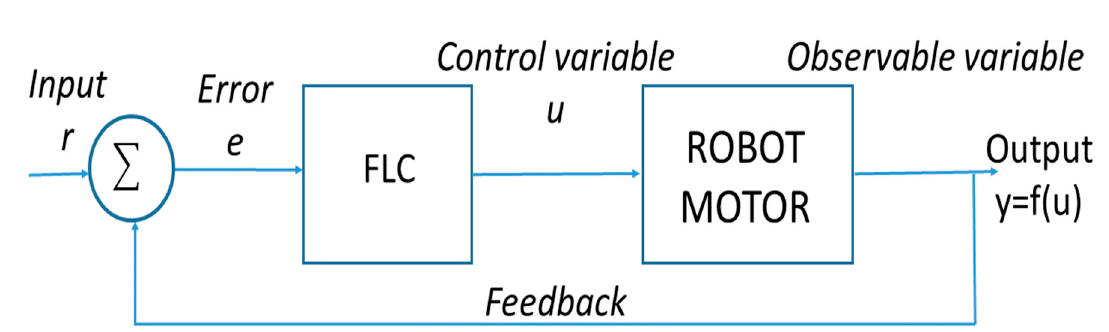
Figure 3. Diagram of an fuzzy logic control (FLC) system .